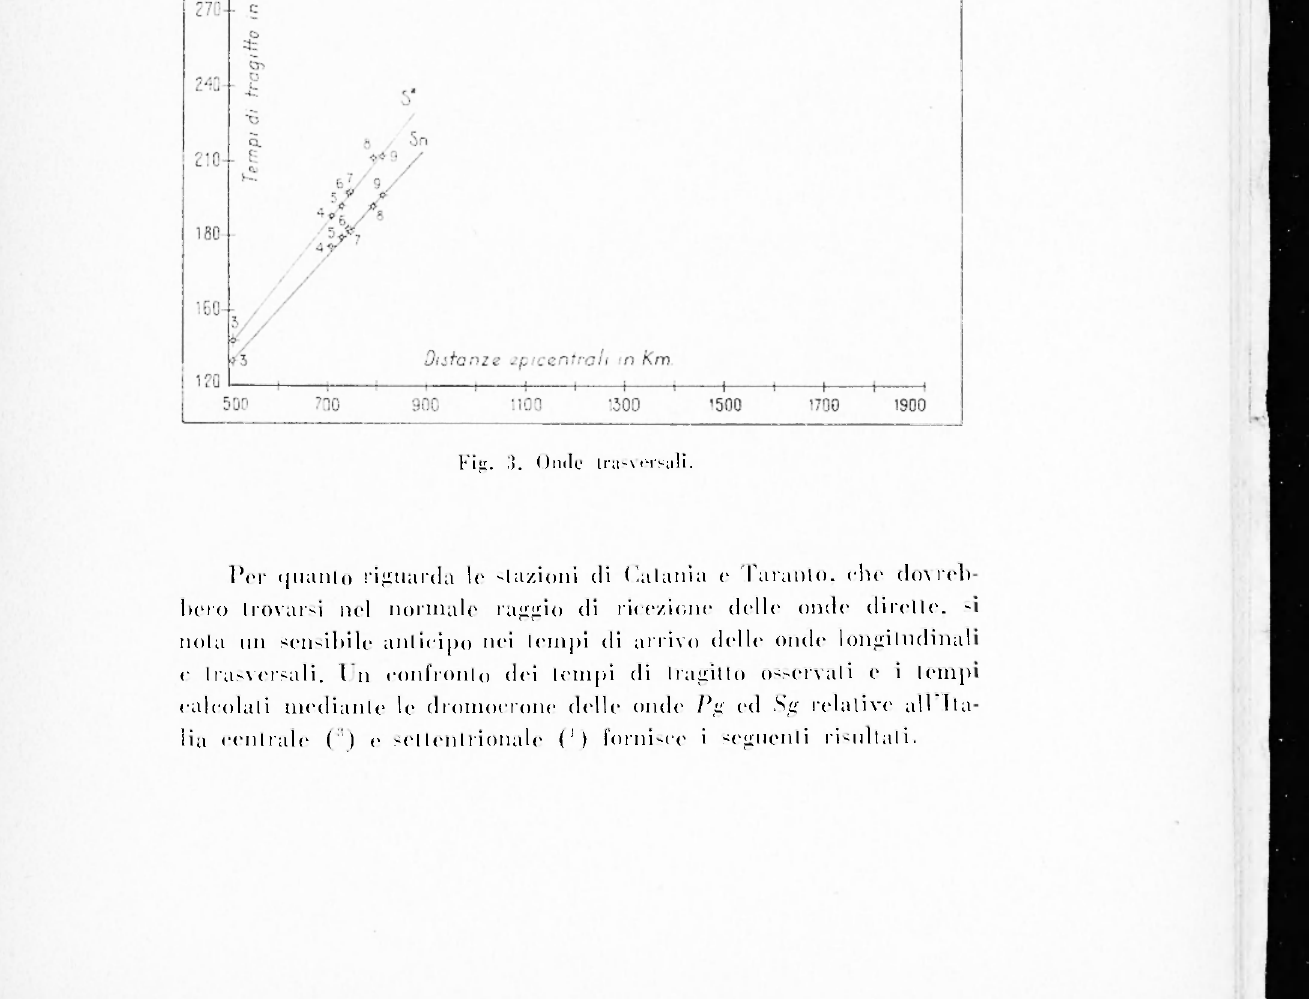
Fig. 3. Onde trasversali.